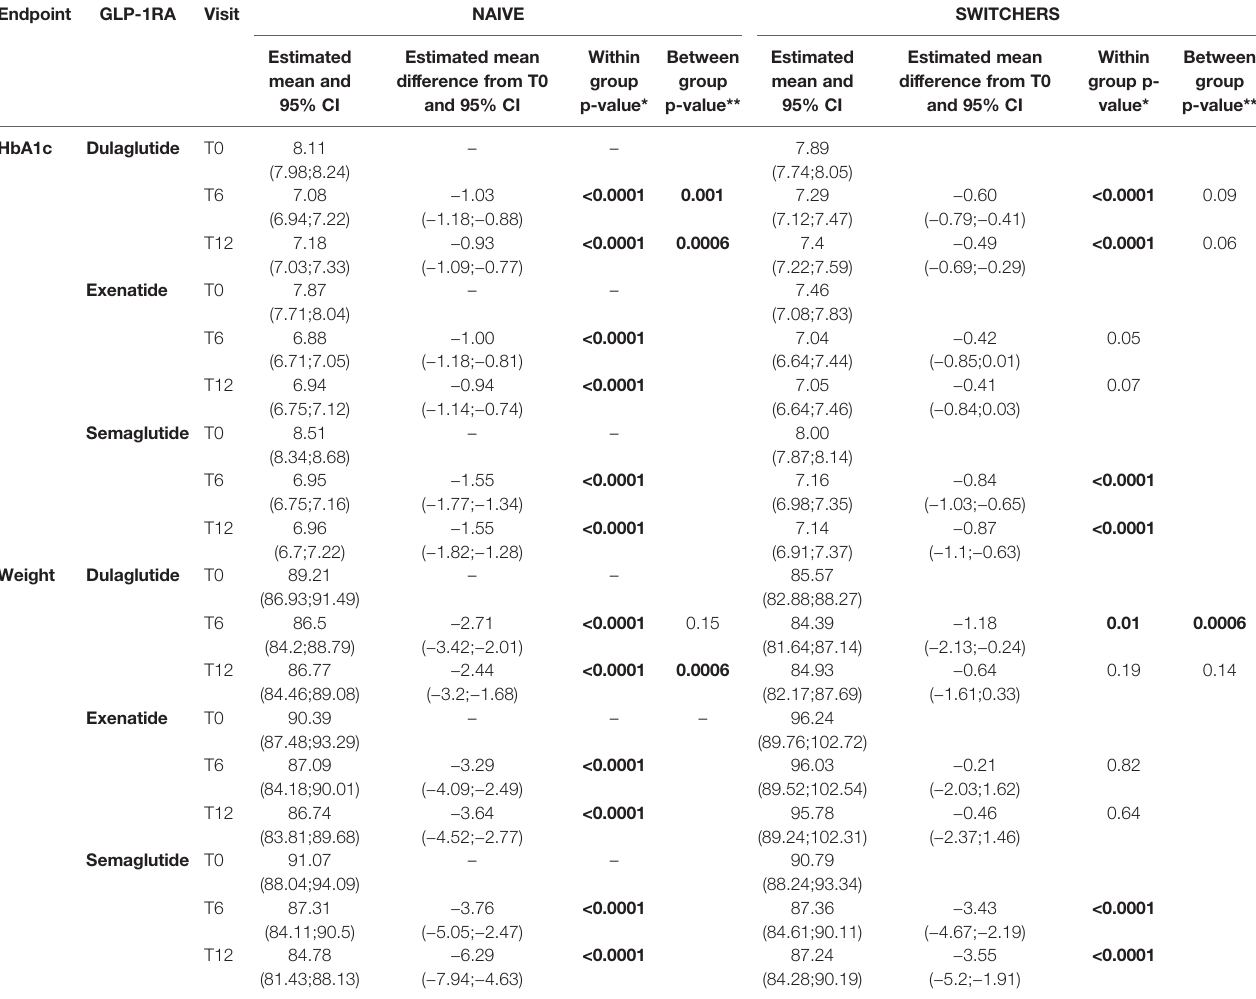
Within-group and between-group comparisons (T6 vs. T0 and T12 vs. T0). *Paired t-test derived from linear mixed models for repeated measurements. **Unpaired t-test derived from linear mixed models for repeated measurements. Statistically signi fi cant p-values (p<0.05) are in bold. *Chi-square test between, OW exenatide, and OW semaglutide. Statistically signi fi cant p-values (p < 0.05) are in